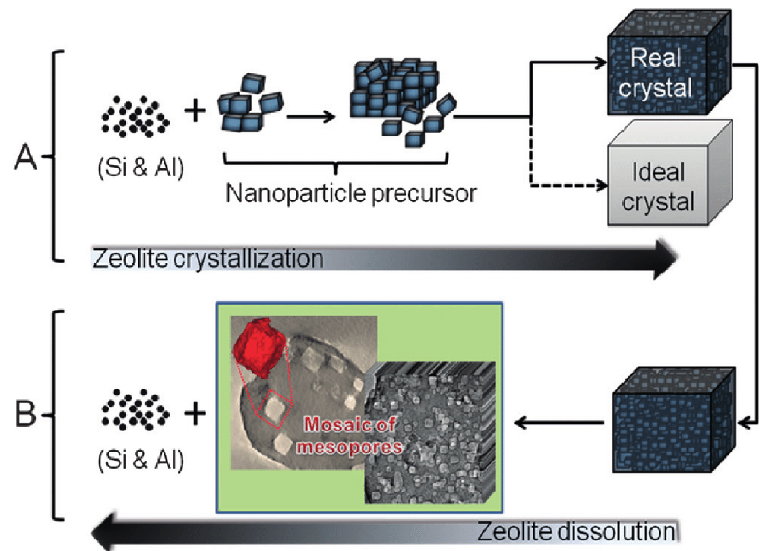
Figure 3. Proposed mechanisms of crystalline zeolite growth ( A ) and dissolution of zeolite crystals via the NH 4 F etching ( B ). Reprinted with permission from [44] . Copyright 2016 Wiley-VCH Verlag GmbH & Co. KGaA, Weinheim.